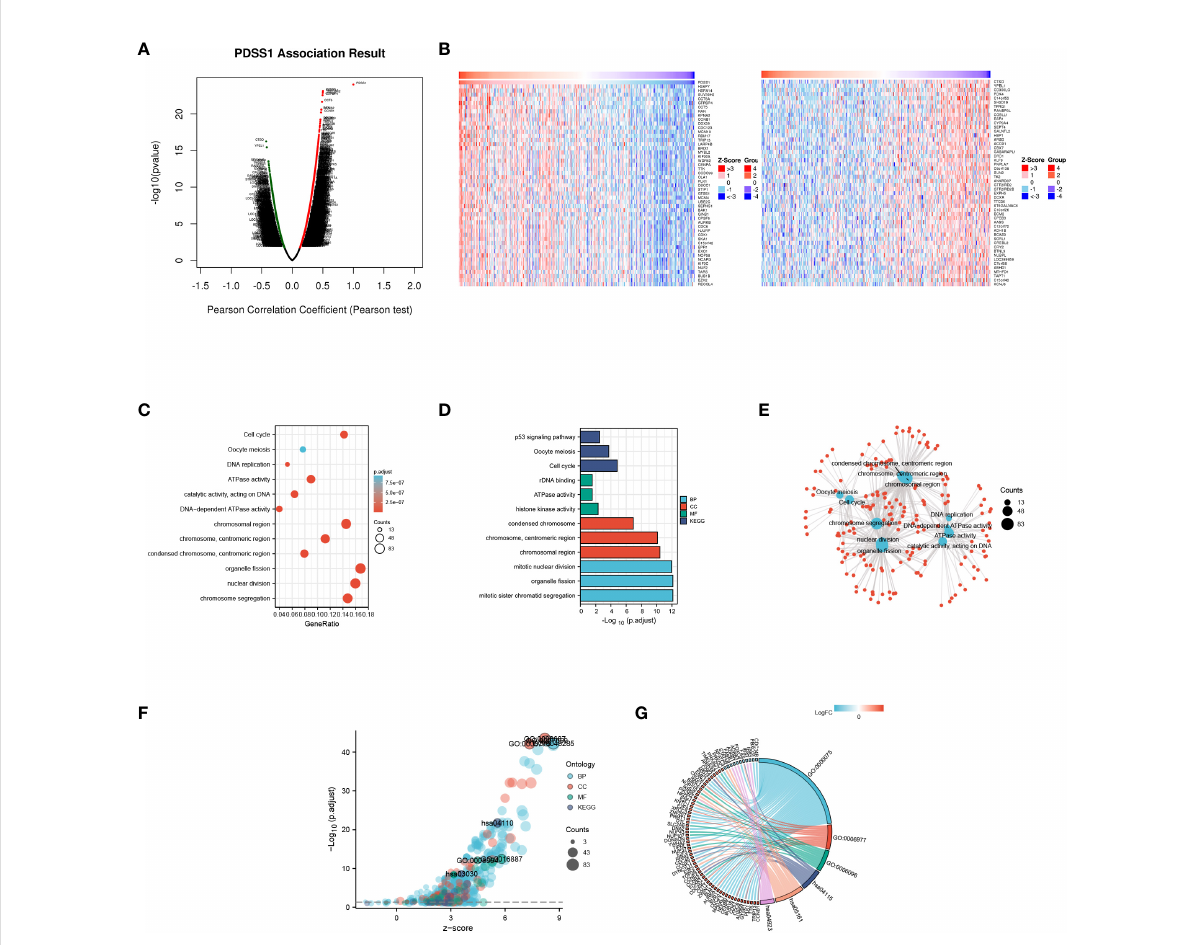
FIGURE 3 Genes co-expressed with PDSS1 in HCC. (A) Highly correlated genes identi fi ed by the Pearson test in the HCC cohort. (B) The heat maps showing top 50 genes positively and negatively correlated with PDSS1 in HCC (left: positively correlated genes; right: negatively correlated genes). (C-F) Signi fi cantly enriched GO annotations and KEGG pathways of the genes co-expressed with PDSS1 in HCC. (G) The co-expressed genes related to cell cycle checkpoint, cell cycle arrest, glycolytic process, p53 signaling pathway, hepatitis B, Regulation of lipolysis in